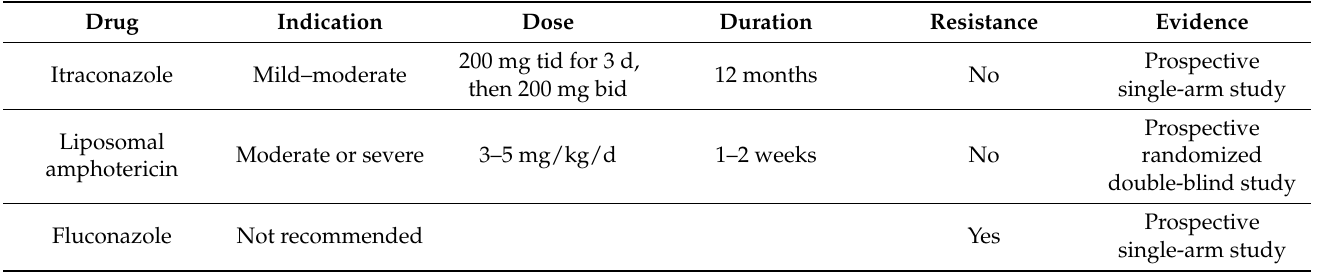
Table 1. Induction therapy for histoplasmosis in adults with HIV